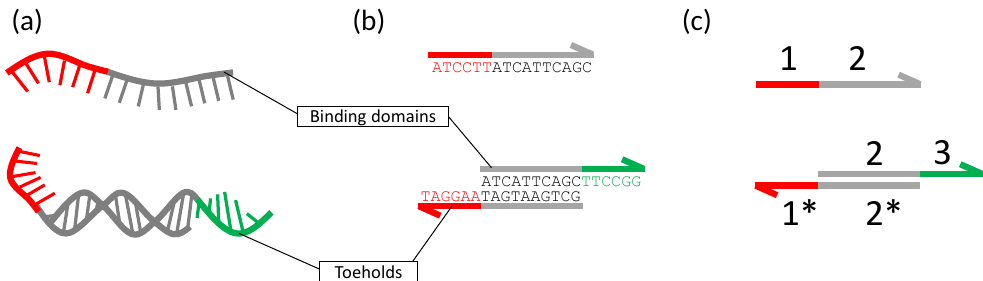
Figure 2. Single- and double-stranded DNA represented in three different manners: ( a ) sugar- phosphate backbones with either forming a helicoidal double structure or exposed sugar bases; ( b ) sequences of bound pairs of complementary sequences of nucleotides; ( c ) numbering the domains, where 2 ∗ is the complementary sequence to the domain